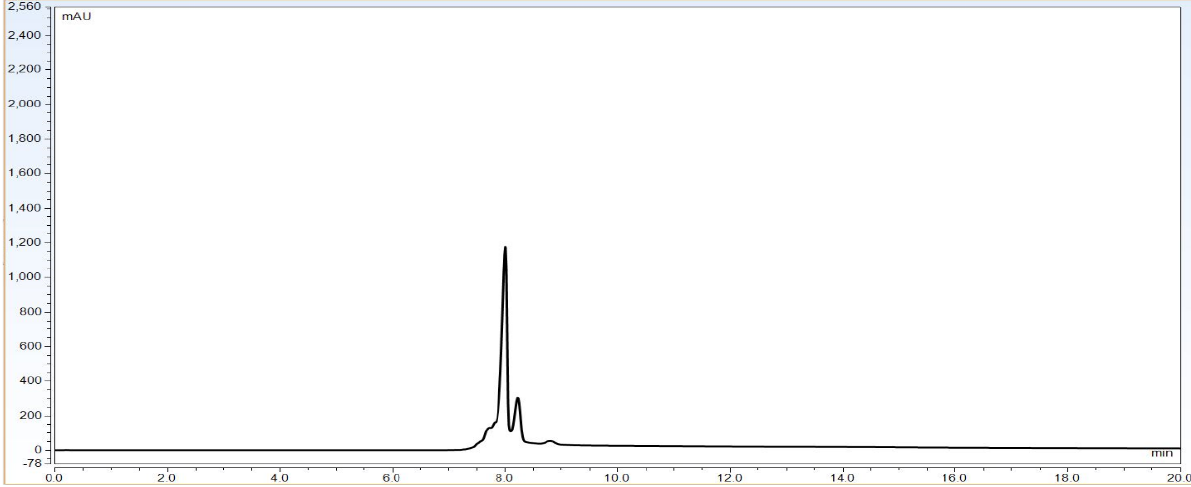
Figure 1. Representative chromatogram of IgG1 antibody using pH based CEX UPLC method. The gradient program and mobile phase information is mentioned in Section 2.